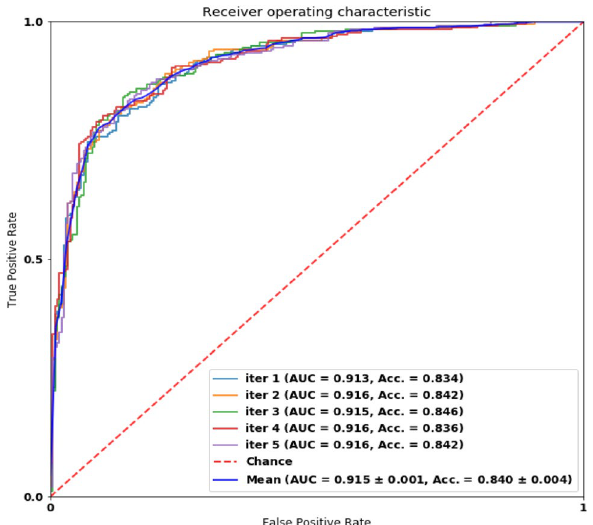
Figure 5. AUROC of classifying AD against HC on the Pitt